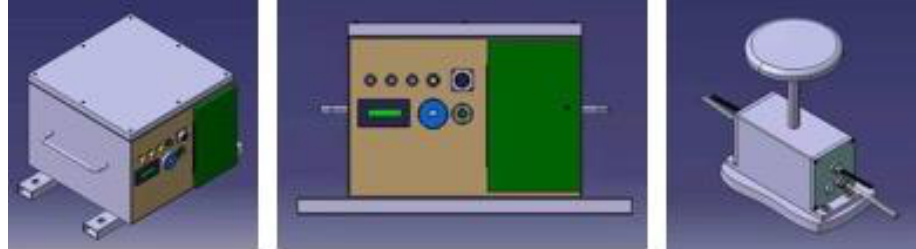
Figure 3. The appearance diagram of the GNSS antenna and static level integration equipment.